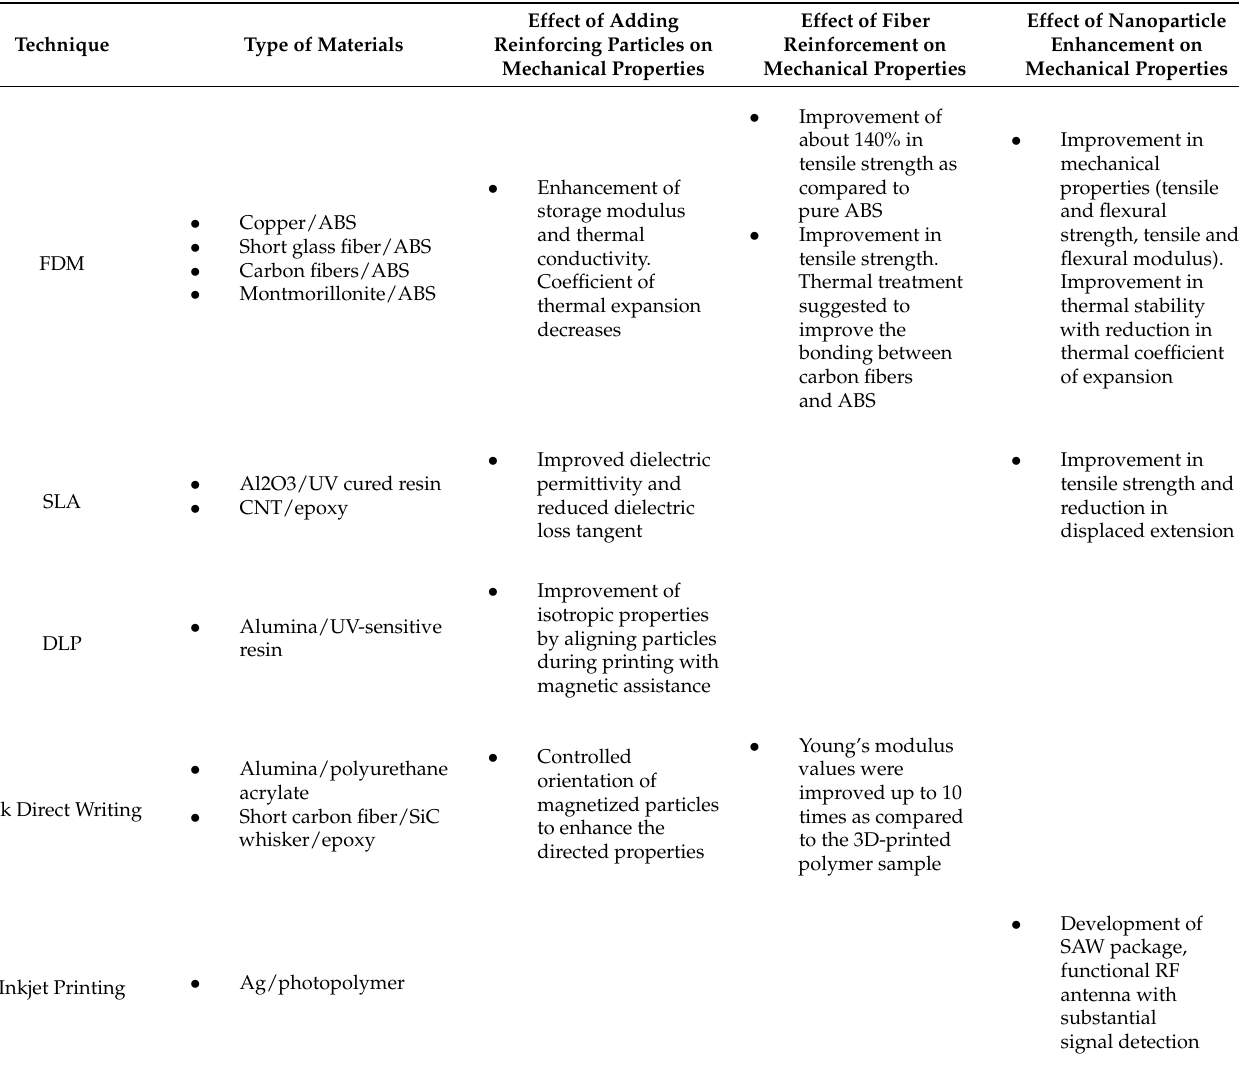
Table 2. Effect of different reinforcement materials on mechanical properties